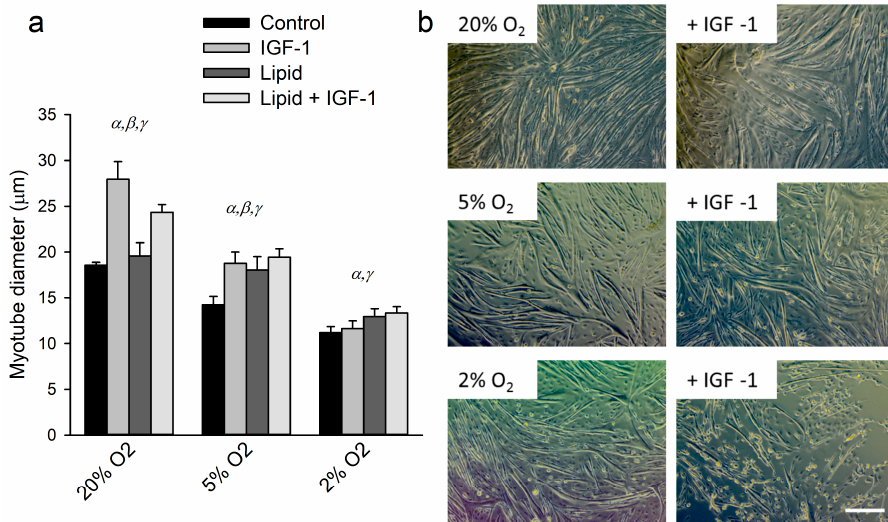
Figure 1. Insulin-like growth factor (IGF)-1-induced hypertrophy is abrogated under hypoxia: ( a ) fiber diameter of myotubes cultured the last 24 h of differentiation under different oxygen tensions, with and without supplementation of IGF-1 and lipid; and ( b ) representative photographs of control- and IGF-1 supplemented cells in all three oxygen tensions. α : significant effect of oxygen tension compared to other O 2 tensions; β : significant effect of IGF-1 treatment within that specific oxygen tension; γ : significant overall effect of lipid supplementation. Values are given as mean ± SEM, n = 6. Scale bar represents 250 µm.